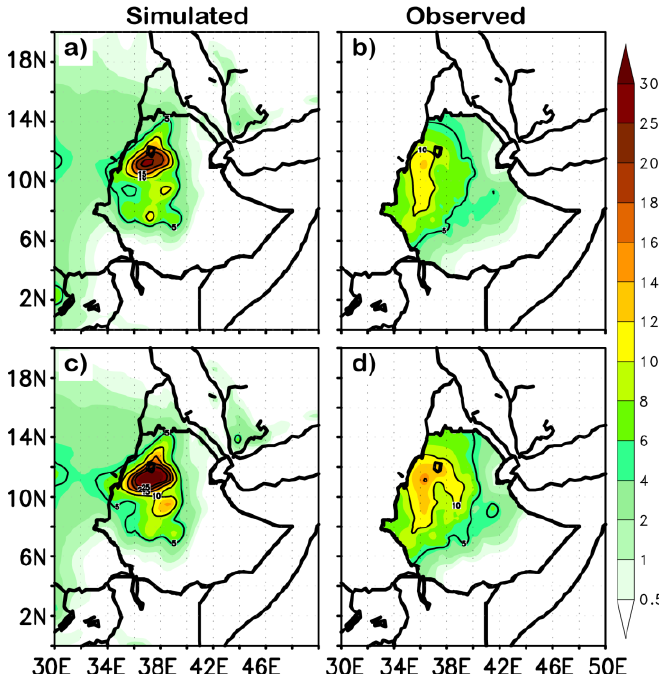
Figure 3. Comparison of CNTRL-simulated ensemble mean ( left ) and observed ( right ) rainfall rates (mm·day −1 ). ( a ) Simulated ensemble mean and ( b ) observed rainfall rates for June–September. ( c ) same as (a) but for July–August. ( d ) Same as (b) but for